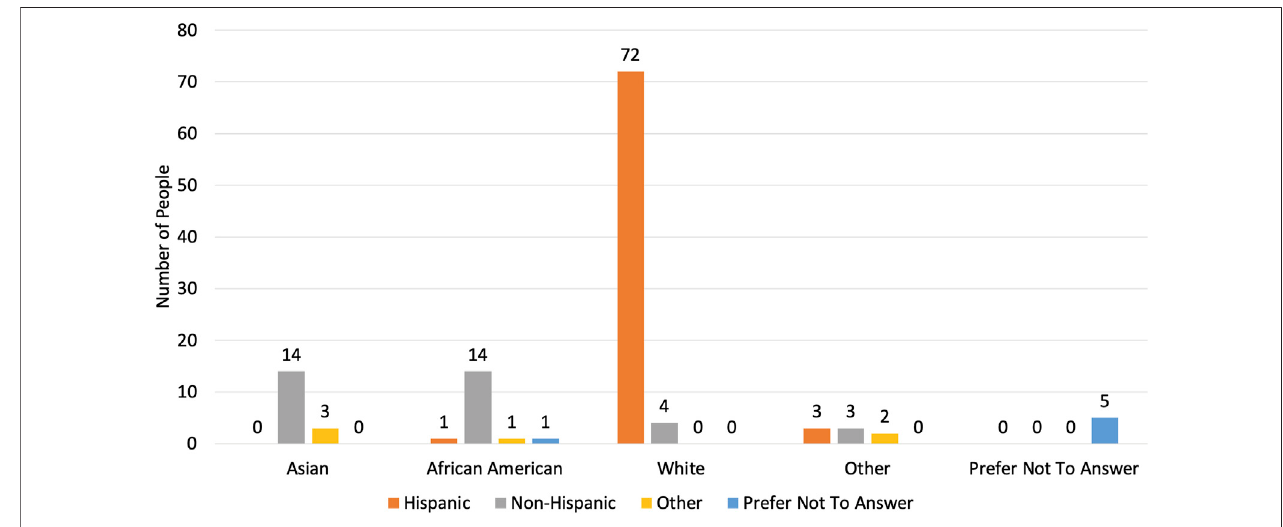
FIGURE 3 | Survey participants ’ ethnicity and race.